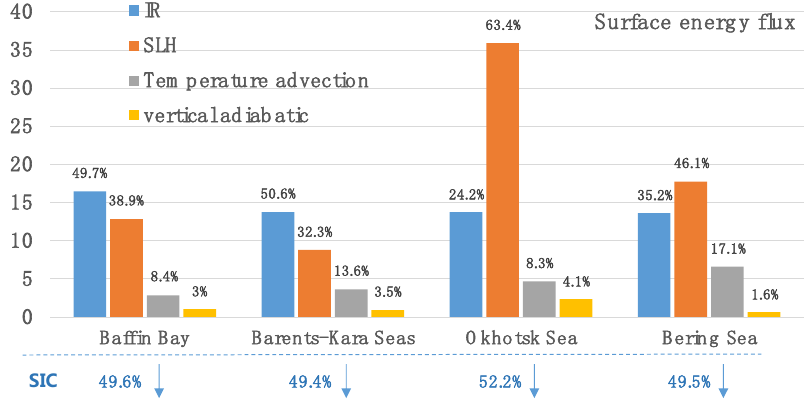
Figure 9. Regional averaged surface energy flux for regions Baffin Bay, Barents-Kara Seas, Okhotsk Sea and Bering Sea during the blocking life cycle from lag −5 to lag 5. The blue box denotes the surface downward IR, the orange box denotes sensible and latent heat (SLH) flux, the gray box denotes the 850-hPa horizontal temperature advection flux and the yellow box denotes the adiabatic heating/cooling induced by vertical velocity. The value at the top of each box indicates the percentage of its component with respect to the total surface energy flux. The number in the bottom line for each region means the percentage of the cumulative decline in sea ice during the lag −5 to lag 20 days with respect to the lag −25 to lag 25 days according to Figure 8 (blue line).